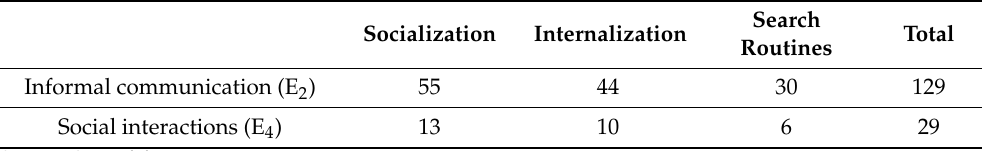
Table 11. Number of alternative routes for knowledge management.